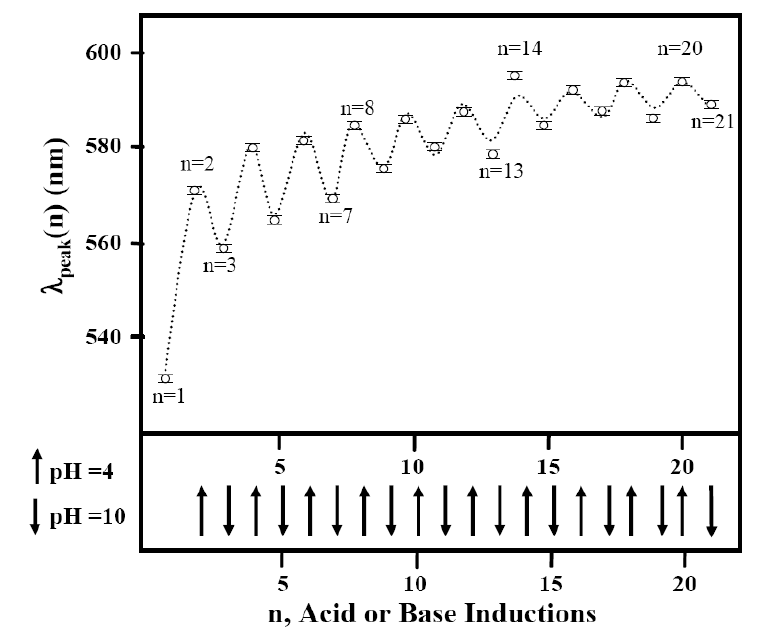
Figure 5. A demonstration of the color change reversibility seen in A  gold colloidal particles (open circles). The upward and downward arrows indicate an injection of HCl and NaOH, adjusting the pH of the solution to pH 4 and pH 10, respectively. The dashed lines indicate the values predicted by Equation